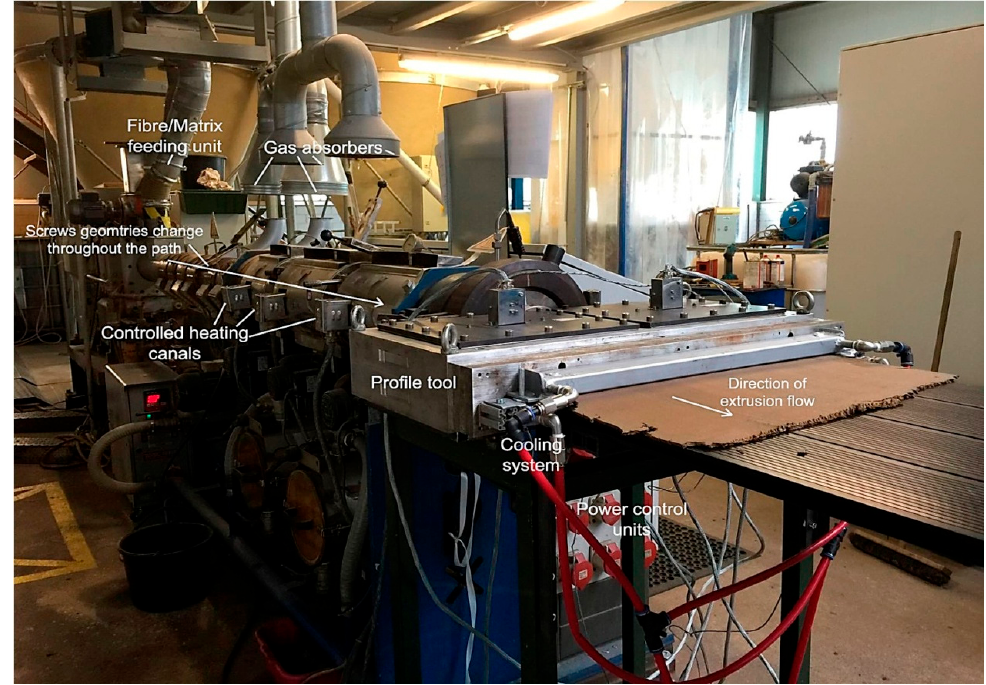
Figure 6. Illustration of the production of Bio-flexi in the mass-production scale indicating the control and feeding units in Naftex GmbH company, Wiesmoor, Germany (Photo: Dahy, H. republished [7]).